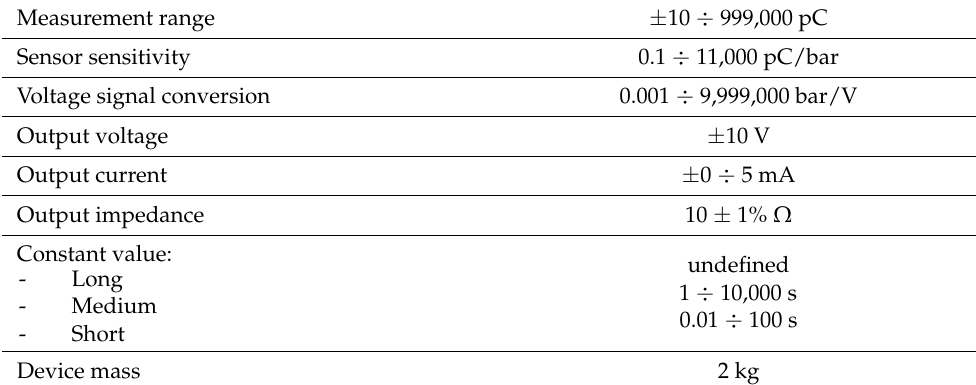
Figure 5. Pressure sensor and signal amplifier [28]. Table 4. Amplifier characteristics